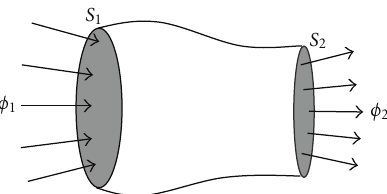
Figure 3: Schematic diagram of geometrical concentration ratio and optical concentration